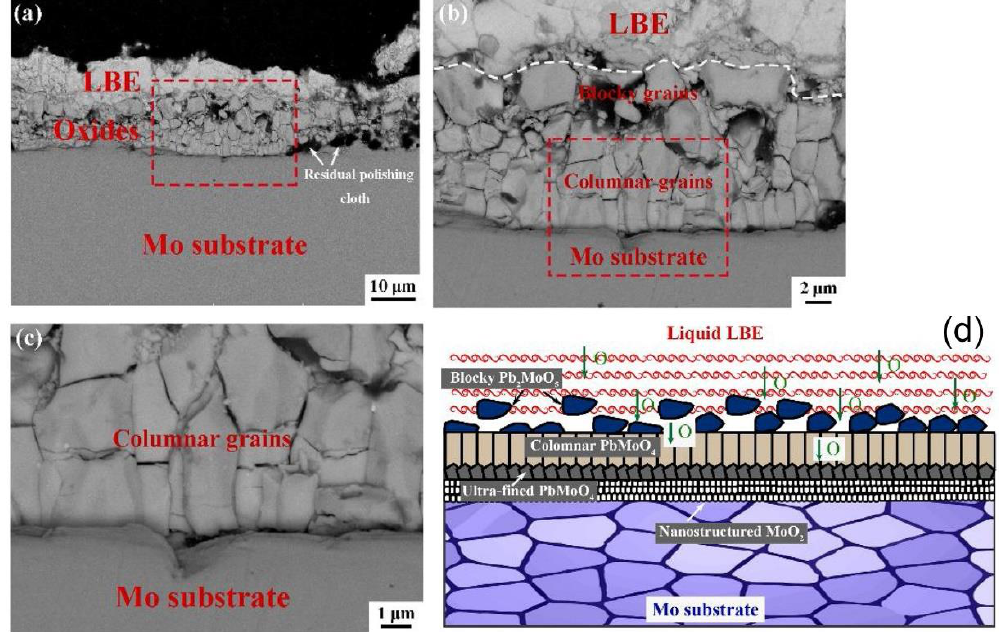
Figure 8. SEM images showing microstructure of Mo corroded in LBE at 600 °C for 20 h ( a – c ), and schematic illustration multilayered oxide layers of Mo after LBE corrosion ( d ) [76]. Figure 8 is reproduced with permission from [76]. Copyright 2021 Elsevier.